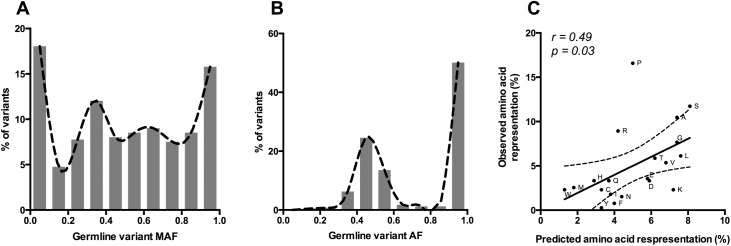
Characterization of germline-somatic variant co-occurrences at the codon level.(A) MAFs of germline variants involved in co-occurrence events. MAFs were derived from all individuals included in the Thousand Genomes Project Phase 3 release. (B) Allelic fraction of germline variants involved in co-occurrence events. (C) Correlation between predicted and observed representation of affected amino acids in co-occurrence events. Each point represents an amino acid labeled with its one-letter identifier. Solid line represents the linear regression and dotted lines represent the 95% confidence interval.